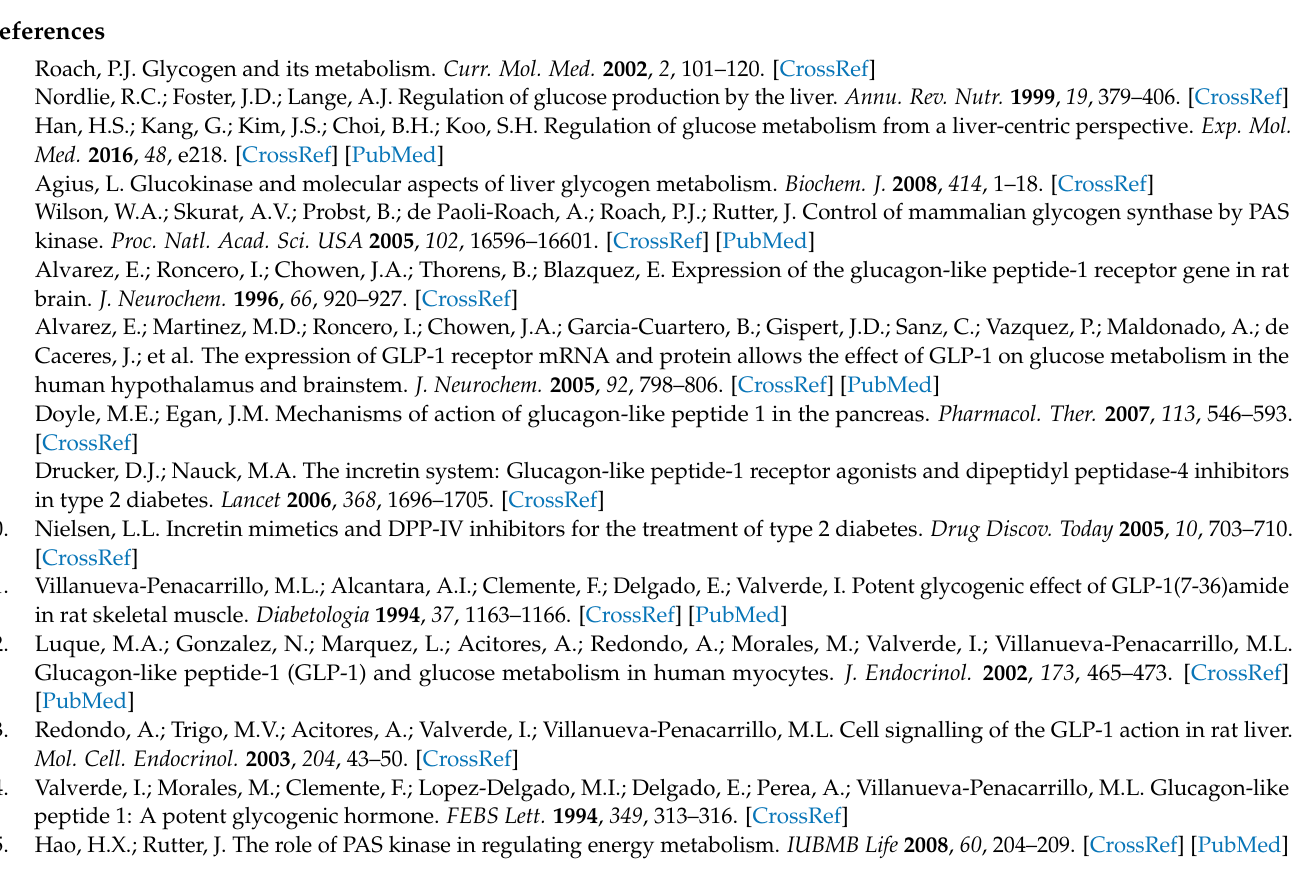
Table S2. Antibodies and conditions used for Western blot assays; Figure S1. Effect of exendin-4 in the expression of hepatic metabolic genes usually activated by feeding; Figure S2: Effect of exendin-4 in the expression of hepatic metabolic genes usually activated by fasting; Figure S3: Effect of exendin-4 in the expression of hepatic metabolic genes usually activated by